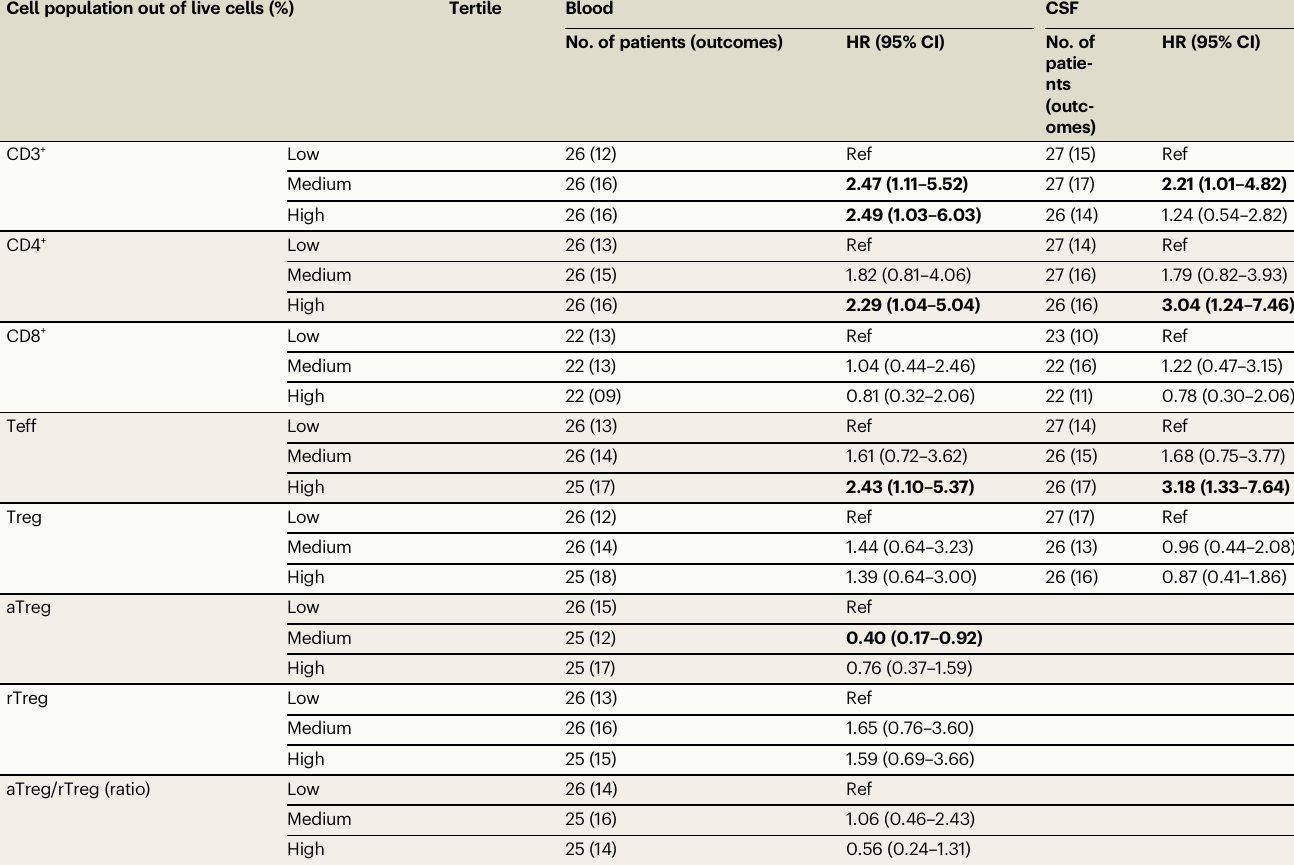
Table 3 | Hazard ratios (HR) and their 95% con fi dence intervals (CI) of death (or use of invasive ventilation) in relation to the frequency of T cell subsets in blood or cerebrospinal fl uid (CSF), after adjustment for age at diagnosis, sex, site of onset, diagnostic delay,disease progression rate at diagnosis, bodymass index (BMI), and the time difference between measurement of BMI and blood sampling Cell population out of live cells (%)